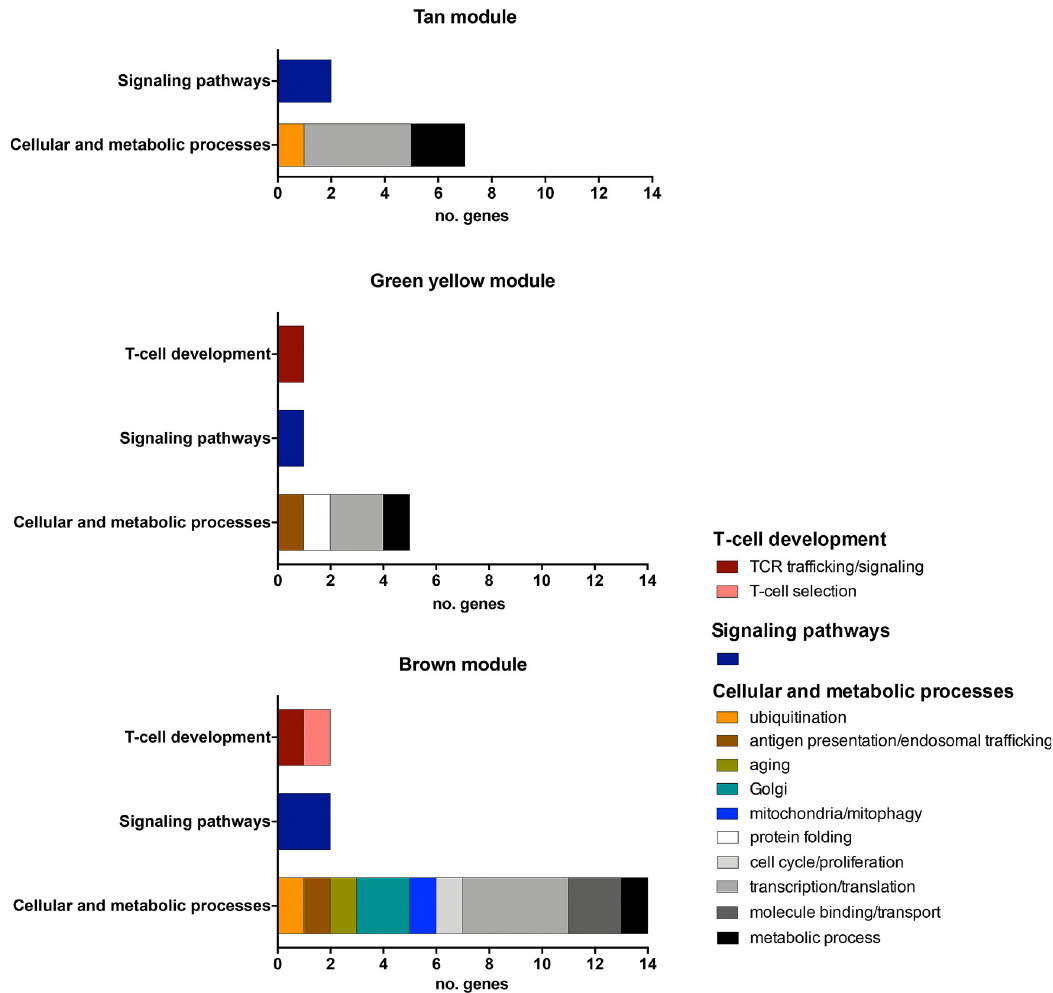
Fig 3. Hub classification according to functional categories. Biological functions assigned to all the 34 hubs distributed in three age-related modules: tan, green yellow, and brown.